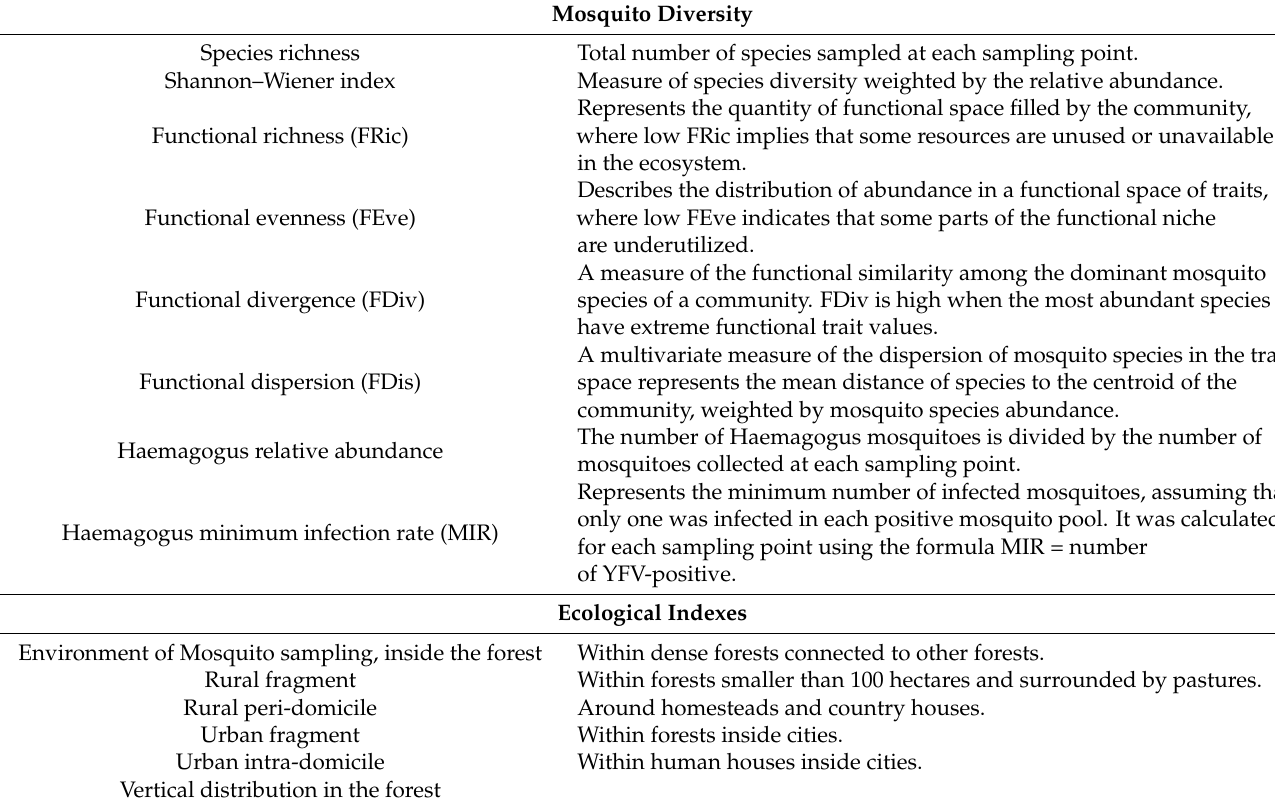
Table 2. The measures related to behavior, physiology, habitats, and epidemiological importance of yellow fever can potentially be implemented in dengue